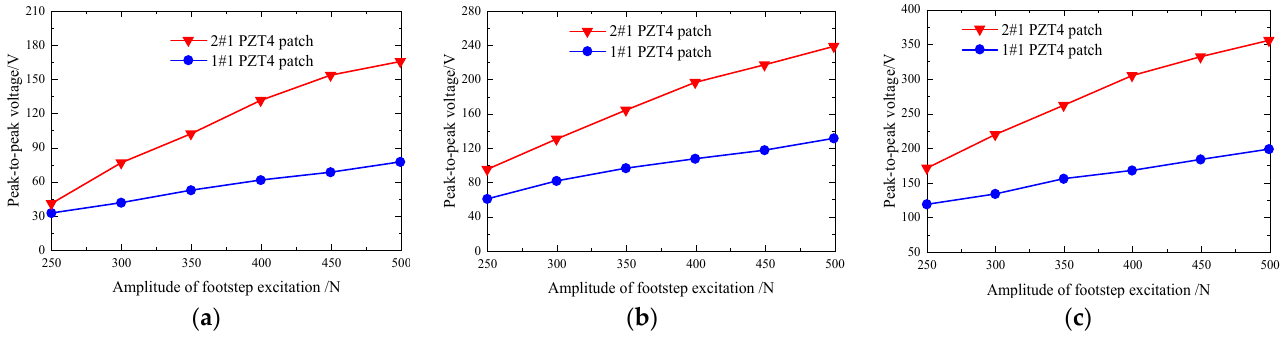
Figure 12. Comparison of peak-to-peak voltages from PZT4 patches of 1#1 on unimorph PCS of 1# piezoelectric brick and 2#1 on unimorph PCS1 of 2# piezoelectric brick versus the amplitude of footstep excitation ( f = 1 Hz). ( a ) L = 19.5 mm; ( b ) L = 26.5 mm; ( c ) L = 33.5 mm.